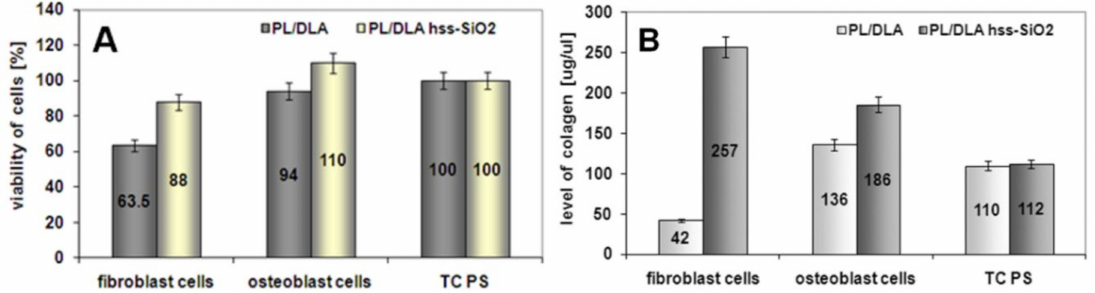
Figure 9. The viability of osteoblast-like cells by hFOB 1.19 cells and fibroblasts HS-5 cells contacted with the nanocomposite materials and the pure polymer foil ( A ). Level of type-I collagen produced by osteoblast and fibroblast cells ( B ). TC PS was used as a reference